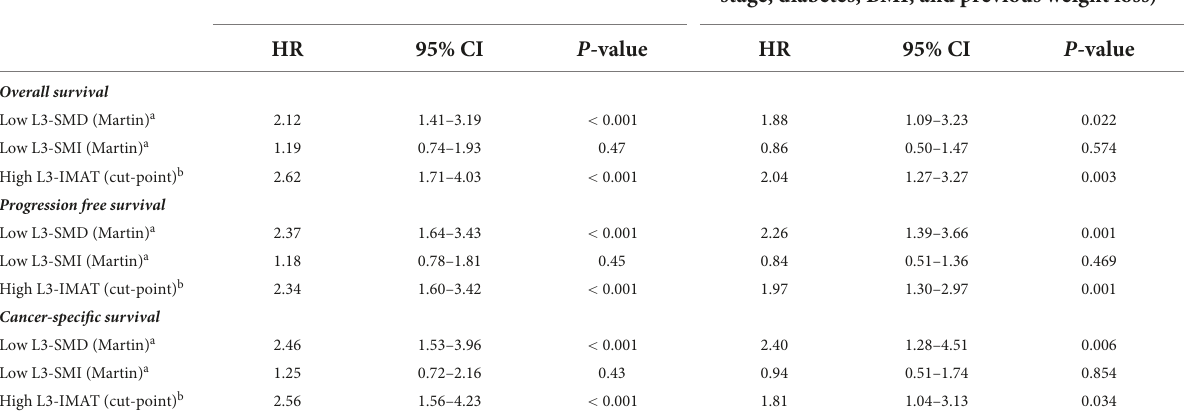
TABLE 4 Univariate and multivariate associations between low muscle quantity (low L3-SMI) and low muscle quality (low L3-SMD or high L3-IMAT) and OS, PFS, or CSS. Univariate analyses